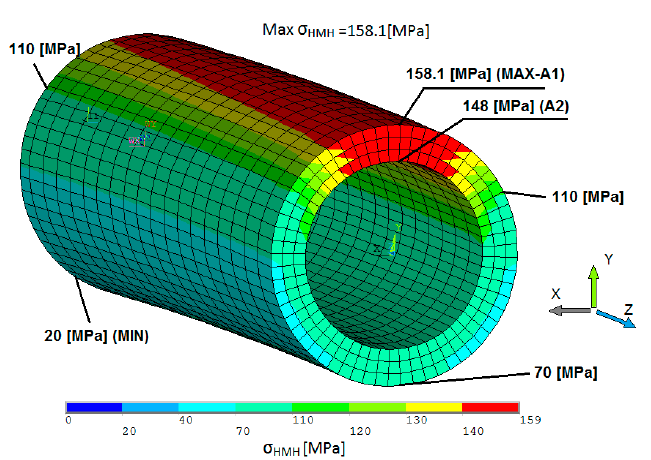
Figure 7. Distribution of equivalent stresses at the initial time of operation ( T = 665 ° C).